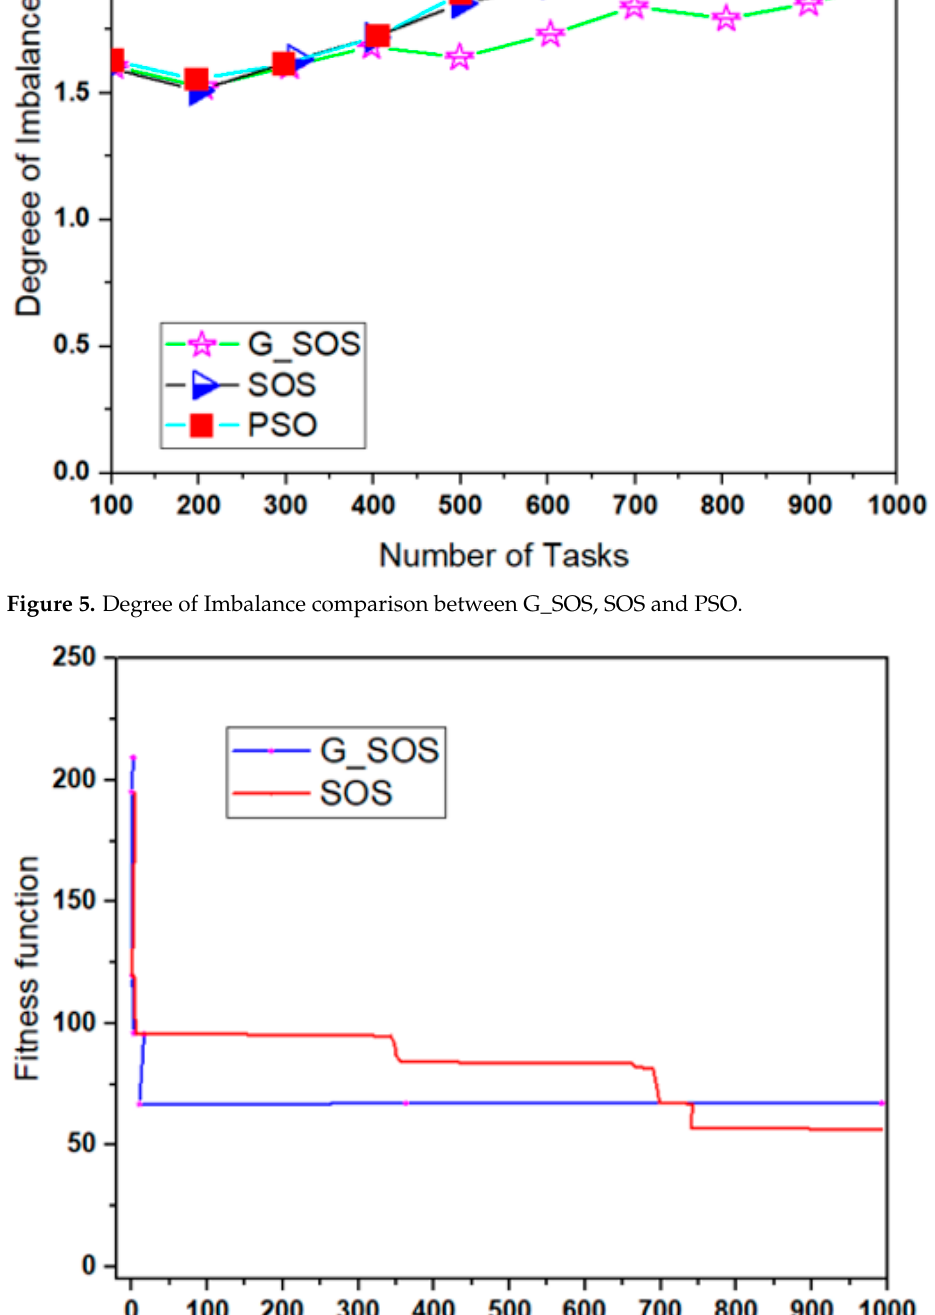
Figure 6. Convergence graph with sample tasks.